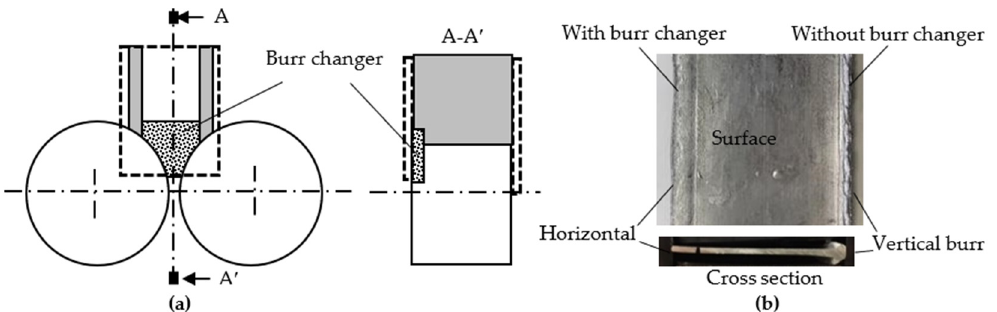
Figure 11. ( a ) Schematic illustration of the of the vertical-type high-speed twin-roll caster (VHSTRC) equipped a burr changer on one side and ( b ) photographs of the surface and cross section of strip cast using the VHSTRC illustrated in (a). Aluminum alloy: A383, Roll diameter: 300 mm, Roll width: 50 mm, Roll speed: 60 m/min, Roll load: 44 N/mm, Solidification length: 100 mm, Distance between a line connecting roll centers and the lowest position of the burr changer: 15 mm.